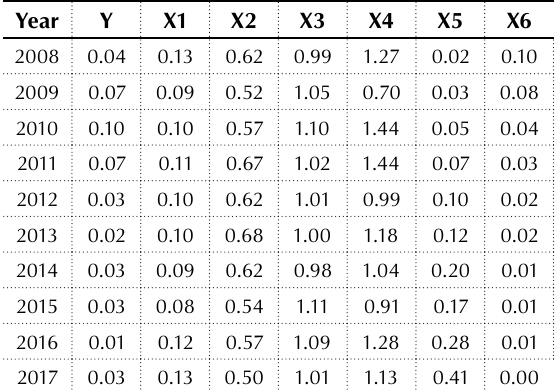
Table 2. Indicators of tax administration of the Republic of Kazakhstan for the period 2008–2017